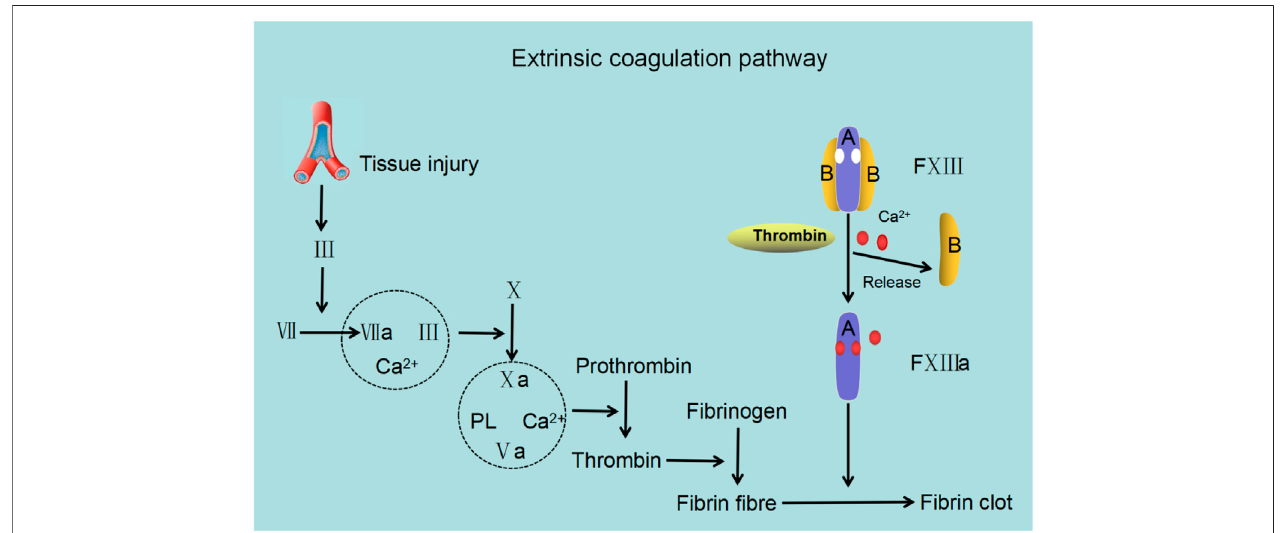
FIGURE 5 | The role of factor XIII in the extrinsic coagulation cascade. Following trauma, factor Ⅲ (FIII; tissue factor) stimulates factor VII (FVII) to form an activated complex(TF – FVIIa)whereinTF – FVIIaactivatesfactorX(FX)toformFXaandconvergesintothecommoncoagulationcascade.InthepresenceofCa 2+ andphospholipid (PL), FXa and its cofactor FVa form the prothrombinase complex (FXa – FVa-PL-Ca 2+ ), which boosts the conversion of prothrombin to thrombin. Lastly, thrombin catalyzes fi brinogentoproduce fi brin,leadingto fi brinclotformationandachievementofhemostasis.FactorX Ⅲ (FXIII)containstwoAsubunitsandtwoBsubunits. TheBsubunitdissociatesfromtheAsubunitwiththeassistanceofCa 2+ andthrombinandexposesCa 2+ bindingsitesresultinginthebindingofCa 2+ andFXIIIfacilitating the stabilization and cross-linking of fi brin to form fi brin clots.